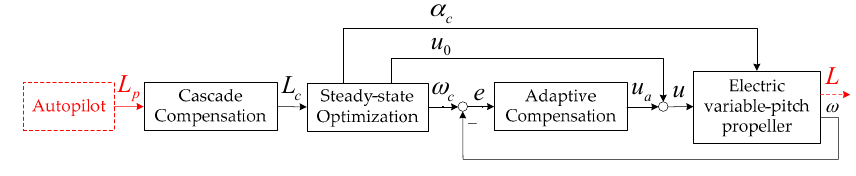
Figure 5. The schematic diagram of the electric variable-pitch propeller.